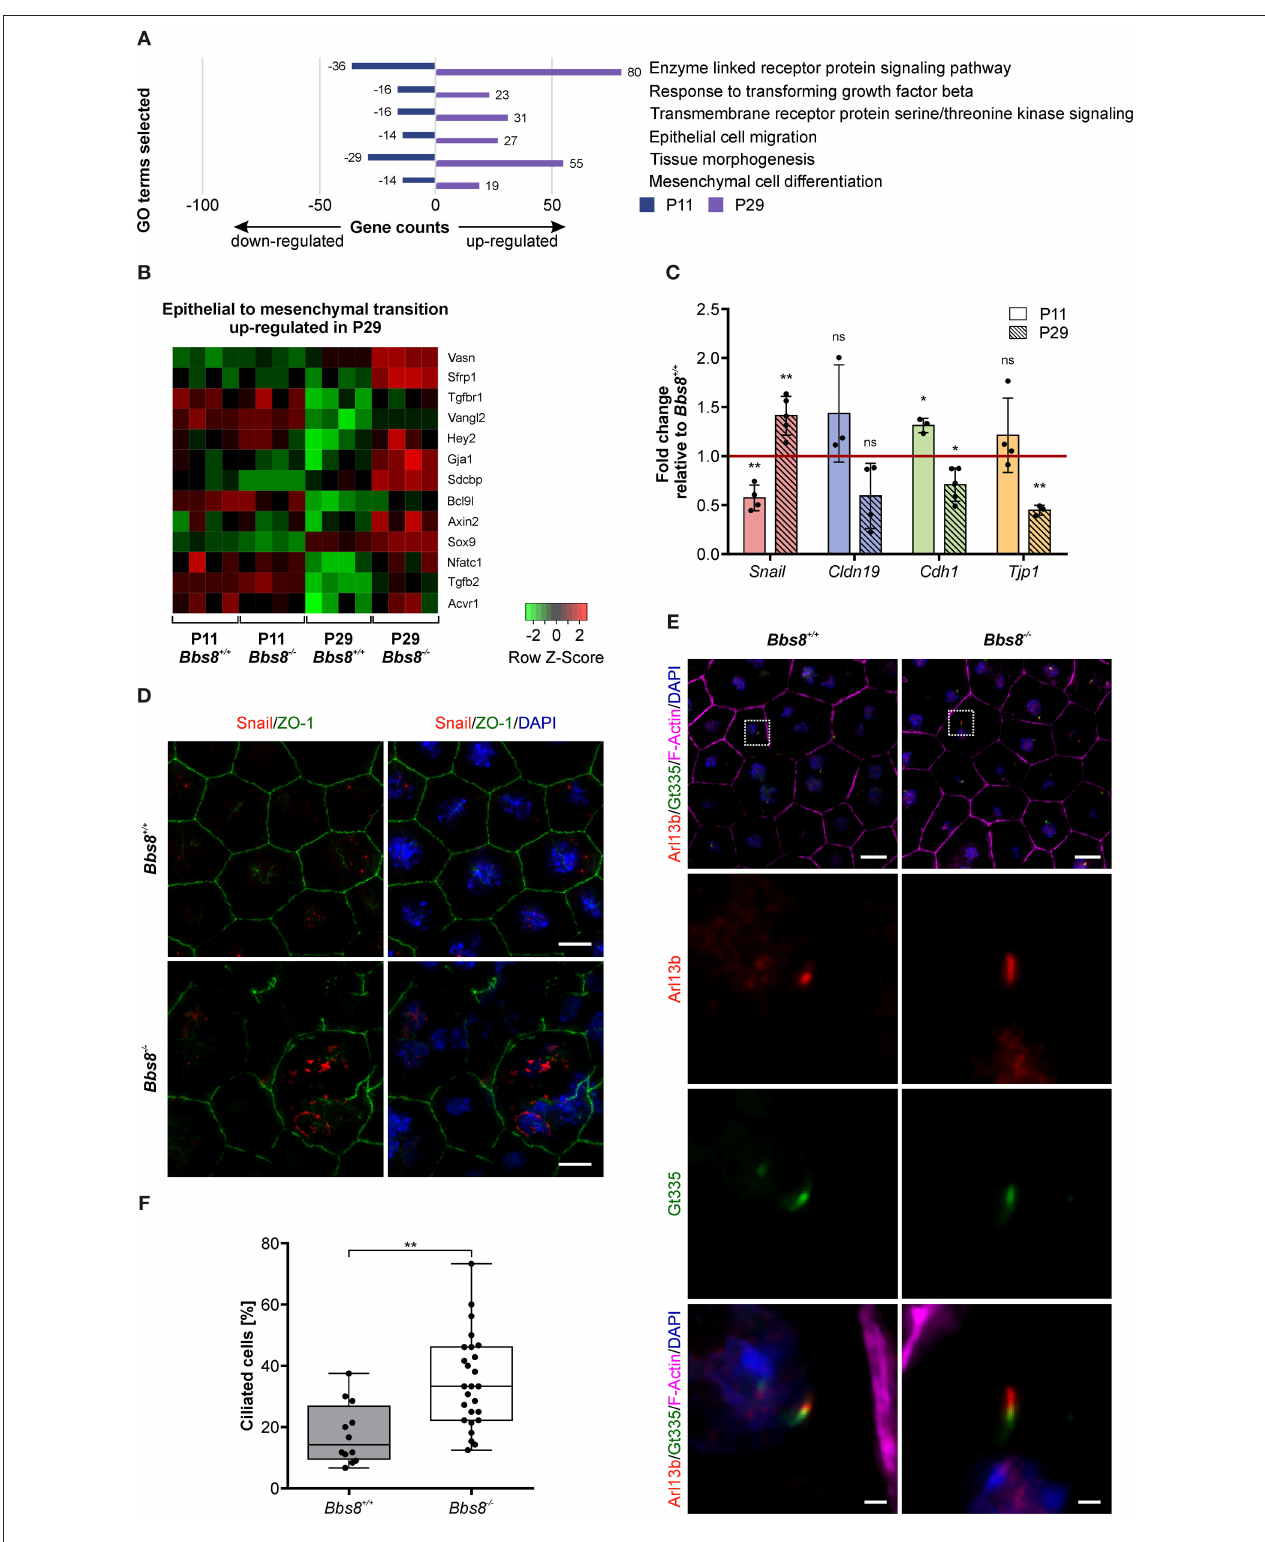
FIGURE 8 | Loss of Bbs8 induces EMT- like traits in the RPE. (A) GO terms associated with differentially expressed genes that were initially down-regulated at P11 and then up-regulated at P29. (B) Heatmap showing DEGs associated with epithelial-to-mesenchymal transition in the four experimental groups. shi (C)